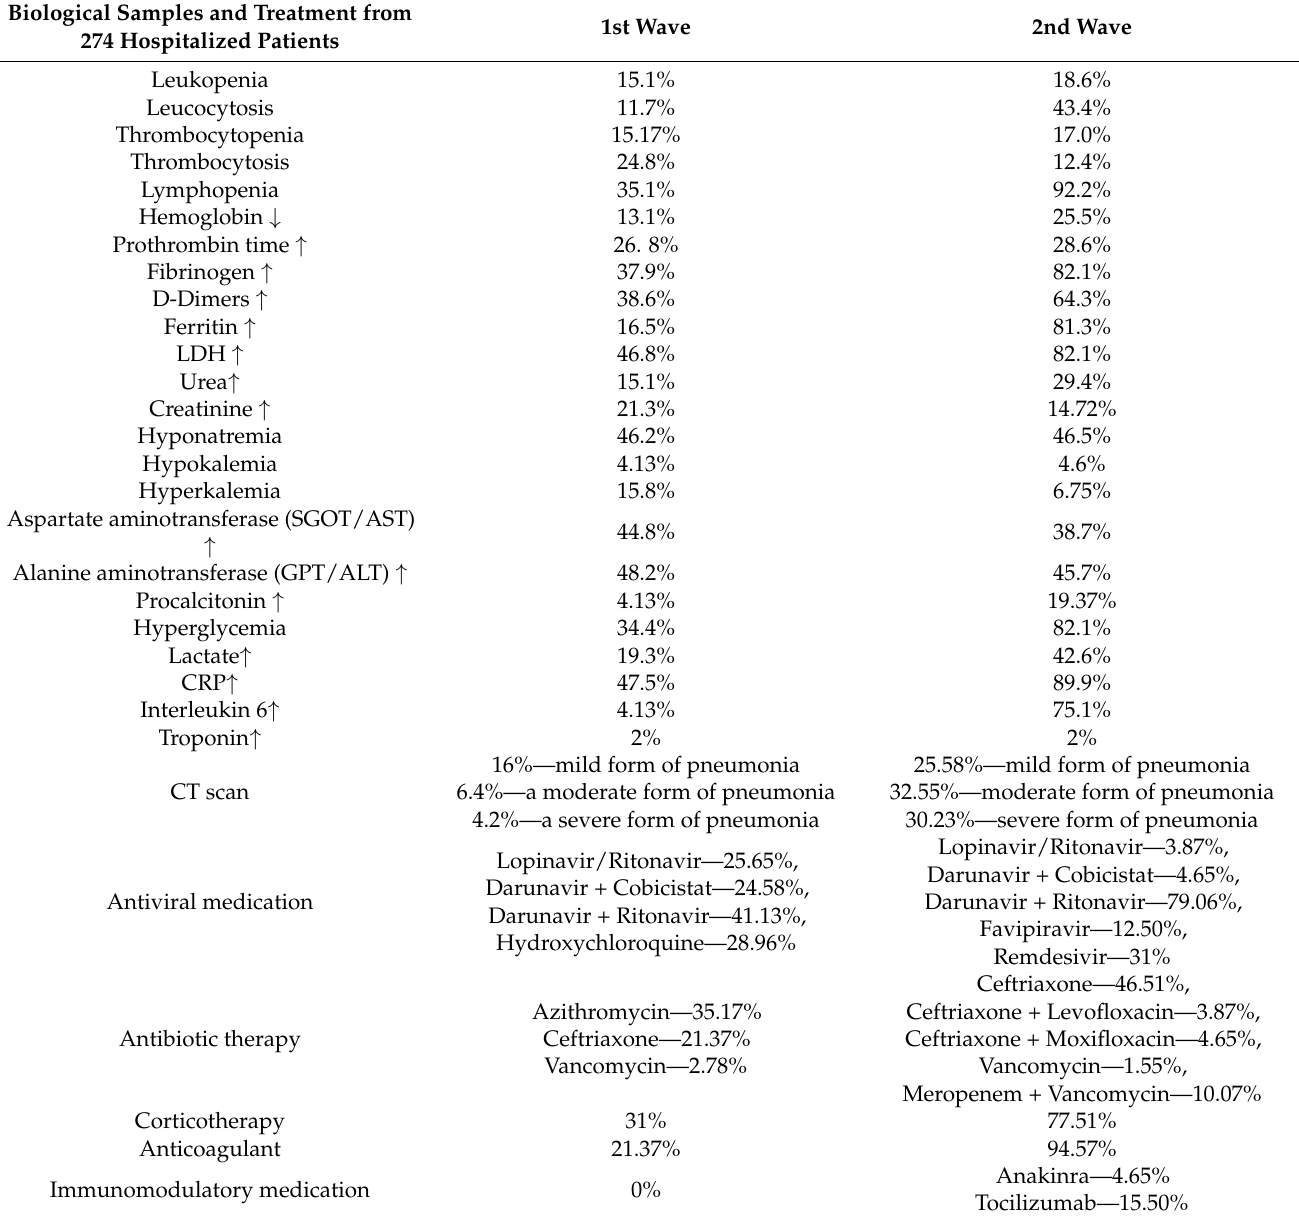
Table 5. Biological samples and treatment schemes for the 274 SARS-COV2 patients considered in the analysis. Biological Samples and Treatment